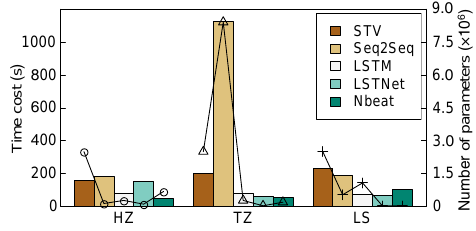
Fig. 9 MAE comparison of STV and STV-Dot.